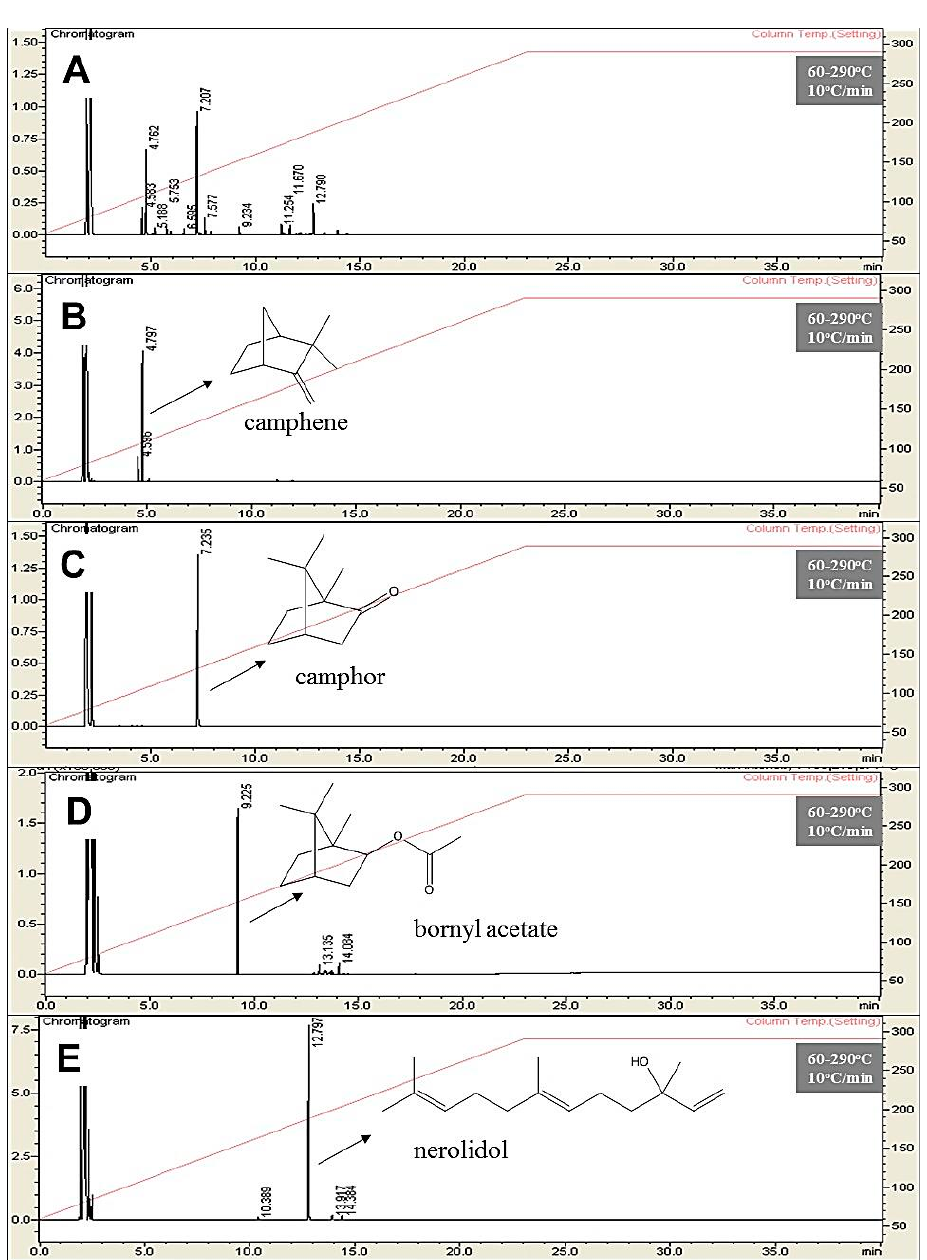
Figure 2. GC-FID chromatograms of P. mollicomum leaf essential oil and high-speed countercurrent chromatography (HSCCC) metabolites separation. ( A ) Crude P. mollicomum leaf essential oil. ( B ) Camphene HSCCC fraction. ( C ) Camphor HSCCC fraction. ( D ) Bornyl acetate HSCCC Fraction. ( E ) Nerolidol HSCCC fraction.